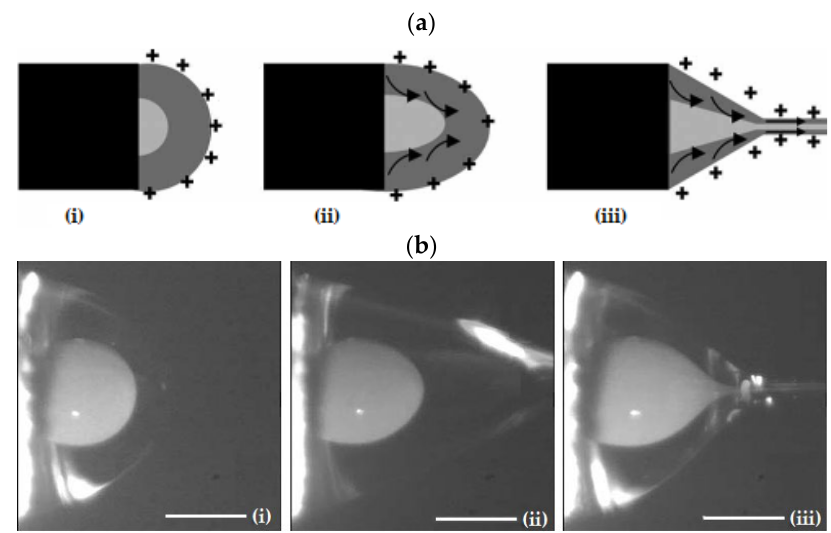
Figure 4. ( a ) Schematic illustration of the formation of a compound Taylor cone: ( i ) Surface charges on the sheath solution, ( ii ) Viscous drag exerted on the core by the deformed sheath droplet, ( iii ) Sheath-core compound Taylor cone formed due to continuous viscous drag). Adapted with permission from [41]. ( b ) Formation of compound Taylor cone menisci and the electrified coaxial jet. Voltage increases from ( i ) to ( iii ) (scale bar 0.5 mm). Adapted with permission (CC BY 4.0) from [42] .